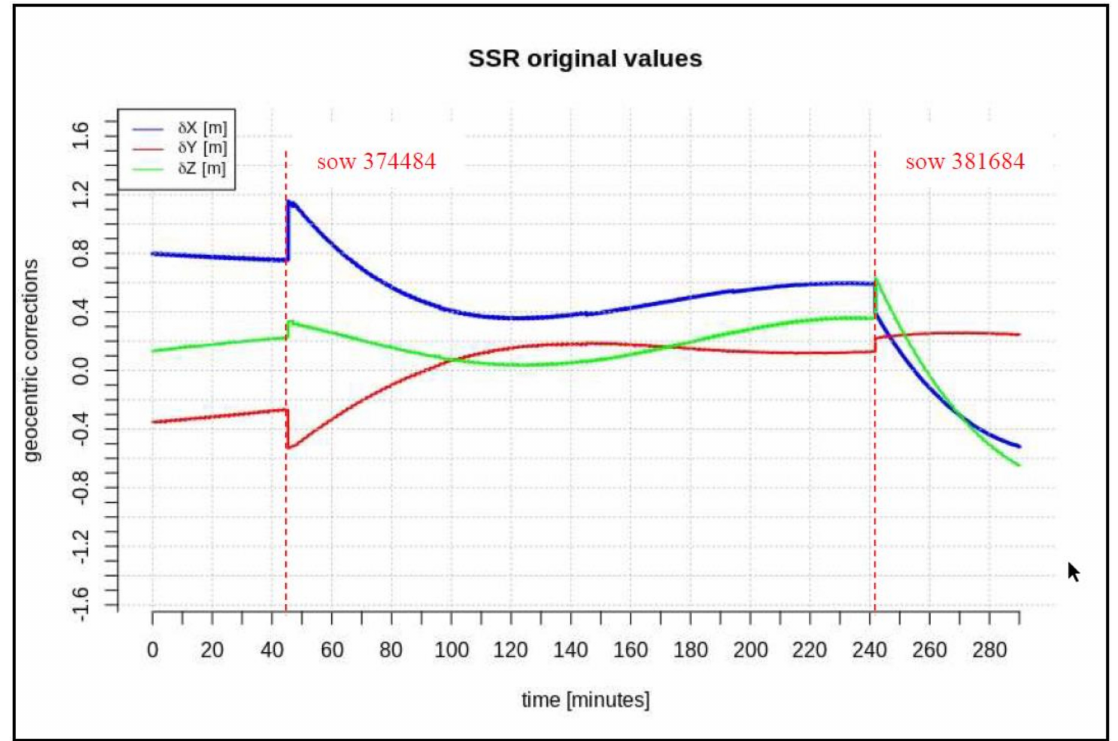
Figure 4. Time series of the geocentric corrections δ P of DOY 102, GPS